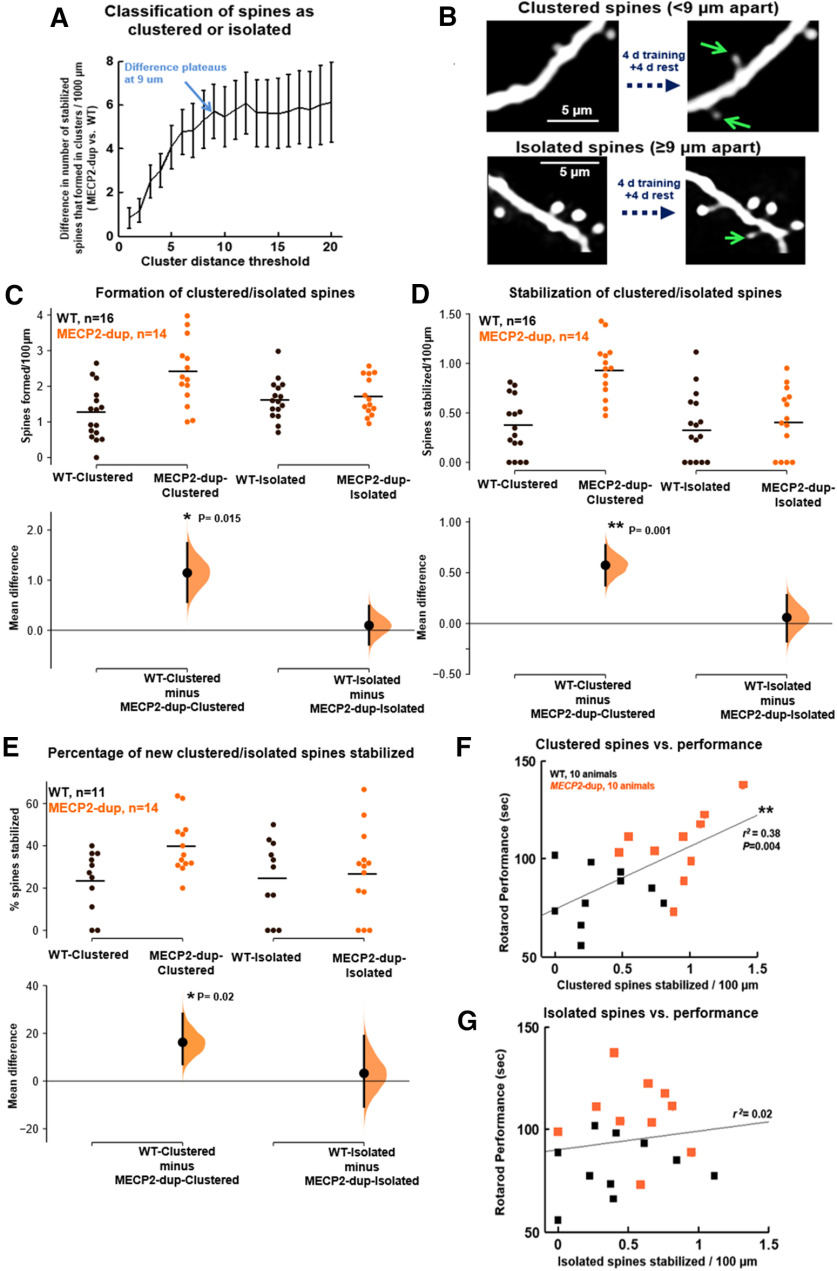
Differential stabilization of clustered and isolated spines in MECP2-duplication mice. A, Determination of cluster distance threshold. Increase in clustered spine stabilization in mutants versus WT littermates, plotted as a function of the cluster distance threshold applied (i.e., the maximum distance to another newly formed spine to be categorized as clustered). Error bars represent the summed SEM from both genotypes. The difference in clustered spine stabilization between genotypes increases with increasing cluster distance threshold leveling off to a plateau at ∼9 μm; 9 μm was therefore chosen for further analysis, and this agrees with the range of spine consolidation cooperativity shown in vitro by Harvey and Svoboda (2007) and in vivo by Fu et al. (2012). B, top, Example of stabilized clustered spines. Bottom, Example of an isolated stabilized spine. C–E, Clustered and isolated spines formed per 100 μm, stabilized per 100 μm, and percentage stabilized from MECP2-duplication mice (orange) and WT (black), visualized as a Cumming estimation plot, as in Ho et al. (2019). Raw data are plotted on the upper axes (dots depict individual data points, horizontal lines depict means). The lower axes show the bootstrapped distribution (light orange) and 95% confidence interval (vertical error bar) of the estimated mean difference between the two groups. Data were pooled across trained and untrained animals. C, Clustered and isolated spines formed per micrometer in each genotype; *p = 0.015, Mann–Whitney U test. D, clustered and isolated spines stabilized per micrometer in each genotype; **p = 0.001. E, Percentage of newly formed clustered and isolated spines that stabilized. Animals that formed fewer than four clustered spines were excluded from the analysis because the percentage measure shows large variability with small numbers of spines; n = 11 WT, n = 14 MECP2-duplication mice; *p = 0.02. F, Stabilization of dendritic spine clusters correlates with enhanced rotarod performance in MECP2-duplication mice (orange) and WT controls (black); **p = 0.004, r2 = 0.38, n = 20 mice pooled across genotypes, Pearson correlation, Student’s t test. G, Stabilization of isolated new spines does not correlate with rotarod performance (r2 = 0.02, p = 0.55), suggesting that clustered spine stabilization is a better predictor of behavioral performance. For visualization of data as mean ± SE with individual data points plotted as circles (untrained) and squares (trained), see Extended Data Figure 3-1.